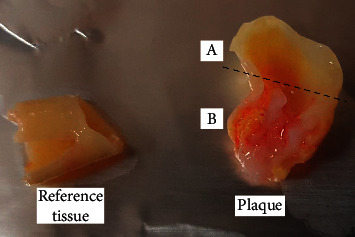
Representative tissue fragments. The fragment A above the dotted line was separated and removed. Fragment B was used as atherosclerotic plaque.